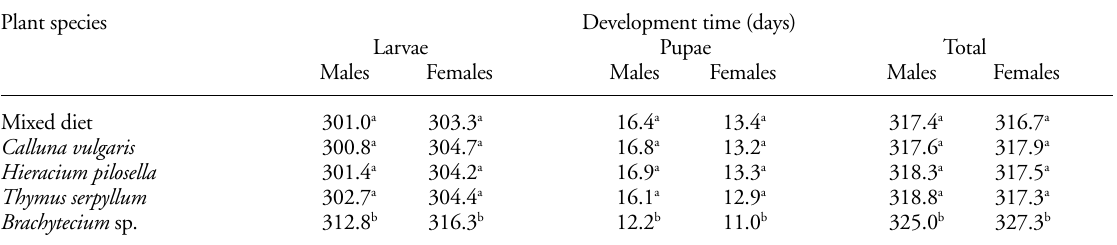
Table 3. Mean development time (days) in preimaginal stages for D. ancilla on different plant species. Cohorts with less than five eclosed adults are excluded from the table.